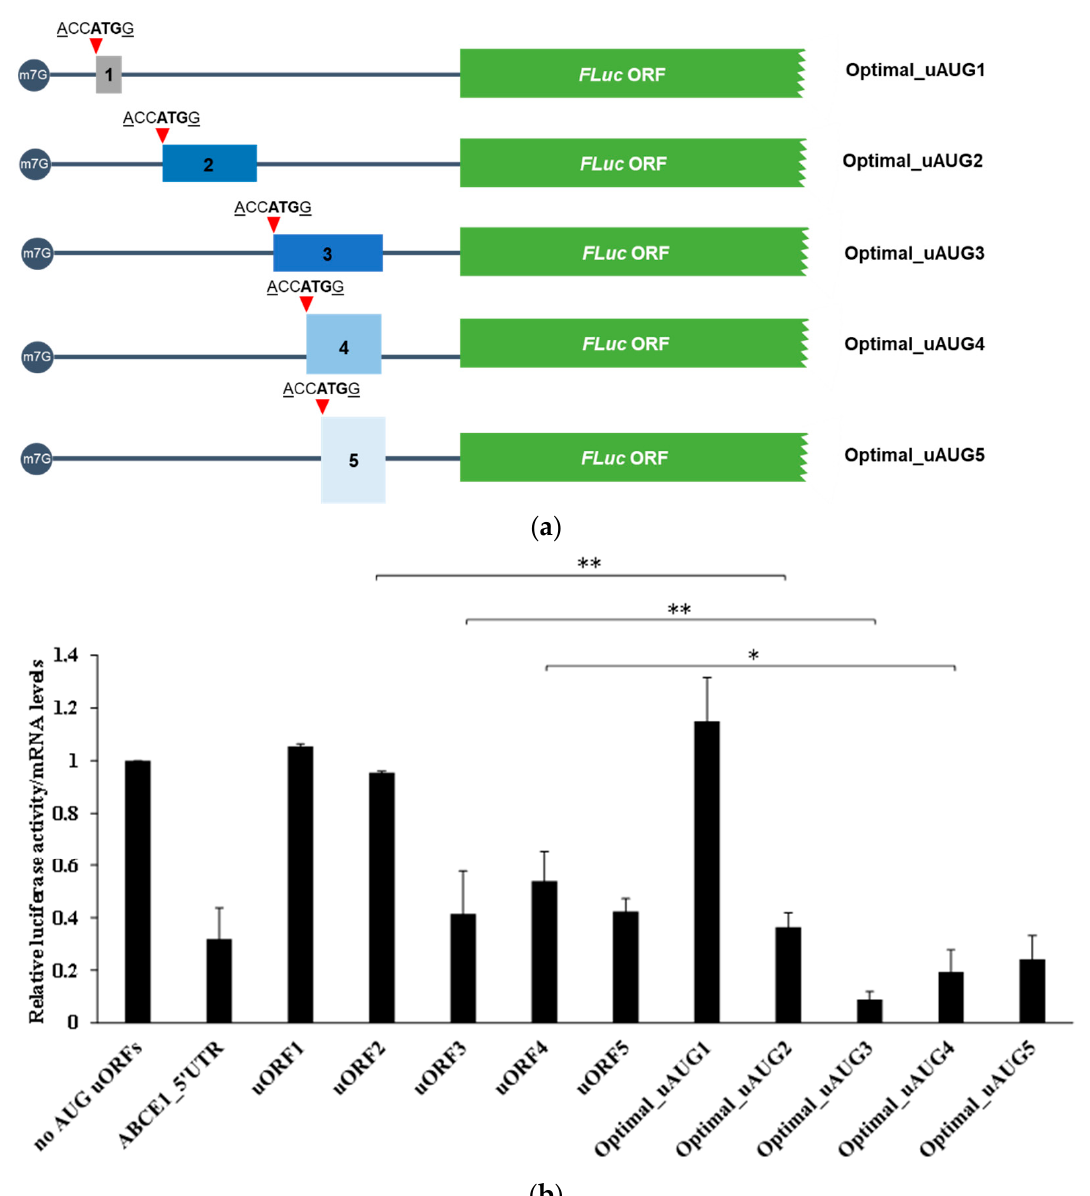
Figure 7. uORF1 and uORF5 present in the ABCE1 5 (cid:48) -leader sequence have the potential to be efficiently recognized and translated by the ribosomes, allowing translation reinitiation to occur at the main AUG. ( a ) Schematic representation of the constructs where the Kozak sequence context of each uORF initiation codon was replaced by an optimal Kozak sequence context (ACCATGG; indicated by the red triangle), obtaining the constructs Optimal_uAUG1, Optimal_uAUG2, Optimal_uAUG3, Optimal_uAUG4, and Optimal_uAUG5. The five non-AUG uORFs are present in these constructs but not represented in the figure to simplify the scheme. ( b ) HCT116 cells were transiently co-transfected with each one of the constructs described in ( a ), or ABCE1_5 (cid:48) UTR, “no AUG uORFs”, or the constructs with only one functional AUG uORF (uORF1-5) already described in Figure 2a, and the pRL-TK plasmid. Expression of these constructs was analyzed as described in Figure 2b legend. The results are presented as mean ± SEM from at least three independent experiments. Student’s t-test was applied for statistical significance: p < 0.05 (*) and p < 0.01